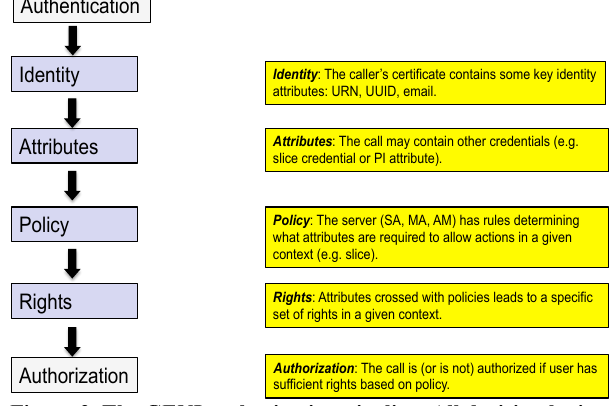
Figure 3. The GENI authorization pipeline. All decision logic are based on attributes and policies.